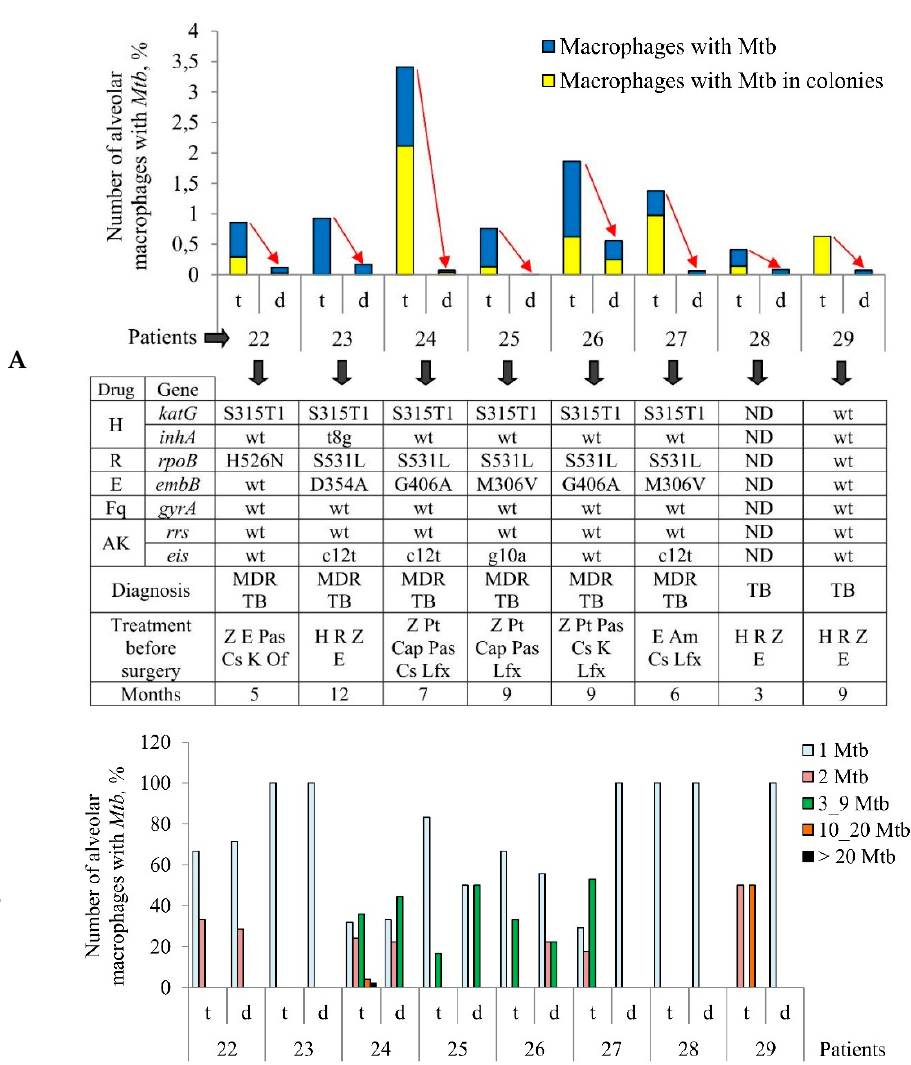
Figure 1. Increased numbers of alveolar macrophages with acid-fast Mycobacterium tuberculosis ( Mtb ) in them are observed in the ex vivo cell cultures obtained from tuberculoma walls (t), but not from lung tissues distant from tuberculomas (d) for the same tuberculosis (TB) patients. ( A ) The number of alveolar macrophages with any Mtb (single or as colonies) and with the colonies of Mtb , some with cording morphology, both expressed as the percentage of the total number of alveolar macrophages stained by the Ziehl-Neelsen method after ex vivo culture for 18 h. The table below the graph shows some characteristics of TB patients 22–29 (updated diagnosis after determination of drug resistance-associated mutations in the Mtb genes, treatment, and the months of therapy before surgery) and the bacteria (mutations in the Mtb genes associated with drug resistance), which infected the lungs of the TB patients. Drugs: AK, aminoglycosides; Am, amikacin; Cap, capreomycin; Cs, cycloserine; E, ethambutol; Fq, fluoroquinolones; H, isoniazid; K, kanamycin; Lfx, levofloxacin; Of, ofloxacin; Pas, para-aminosalicylic acid; Pt, protionamide; R, rifampicin; Z, pyrazinamide. ND, not determined; wt, wild type. Red arrows indicate a trend in the alteration of Mtb loads in alveolar macrophages between various lung lesions for the same TB patients. ( B ) The increased quantity of Mtb is detected in alveolar macrophages obtained from tuberculoma walls, but not from the lung tissue samples for the same TB patients. The number of alveolar macrophages with different numbers of Mtb expressed as the percentage of the total number of alveolar macrophages with Mtb after ex vivo culture for 18 h. Table 1. Cells on histological sections and in ex vivo cell cultures ( 1 ) obtained from the tuberculoma walls (t) and the lung tissues distant from tuberculomas (d) for the same TB patients. Patient No. Lung Tis- sue Mycobacte- rium tuber- culosis ( Mtb ) in Caseum 2 Pneu- mocytes